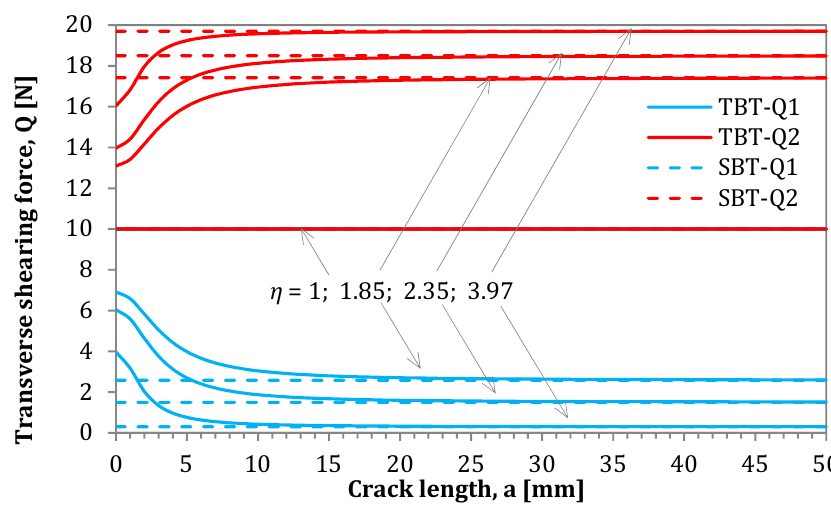
Figure 12. Magnitudes of transversal shearing forces in the delaminated part of the AENF specimen.